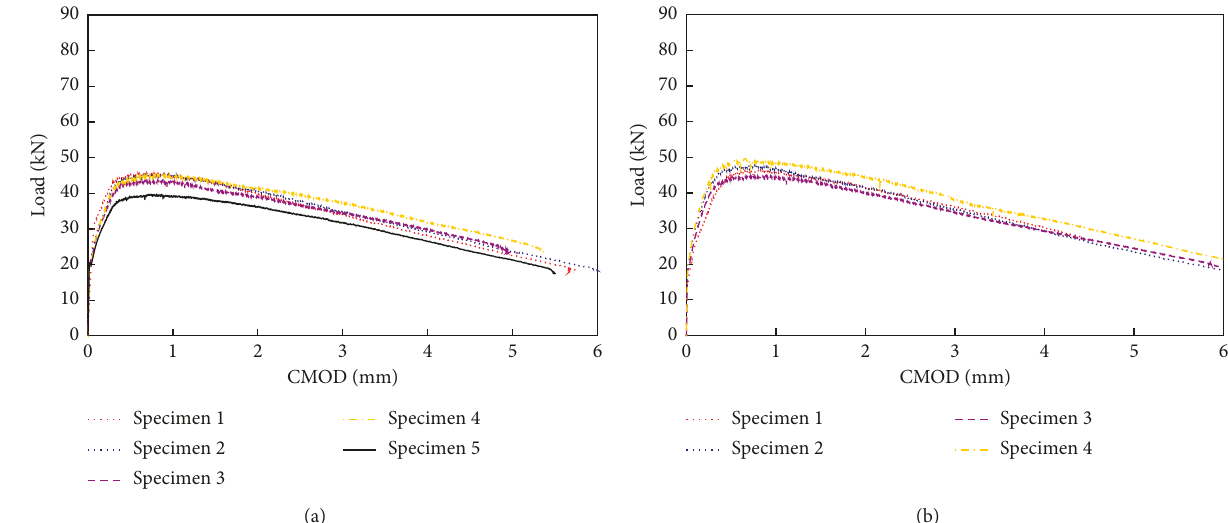
Figure 5: Comparison of the load-CMOD curves of the F10 series mixtures. (a) F20-S-L130 mixture. (b) F20-H mixture.